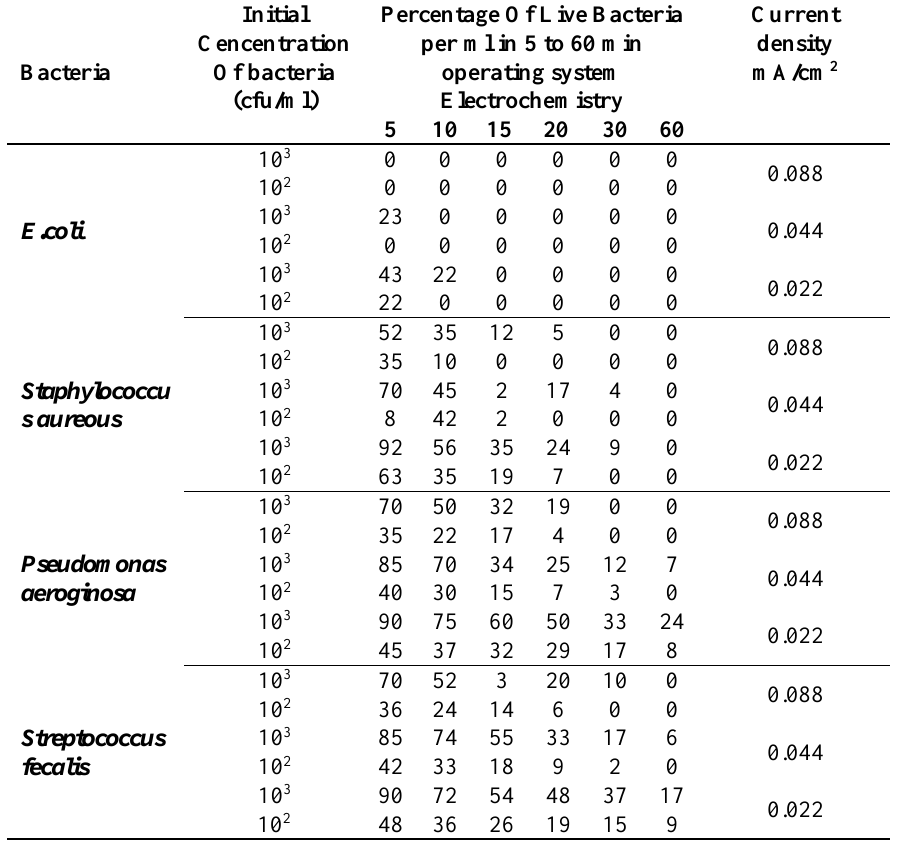
Table 1 Percentage of live bacteria after electrochemical process with different current